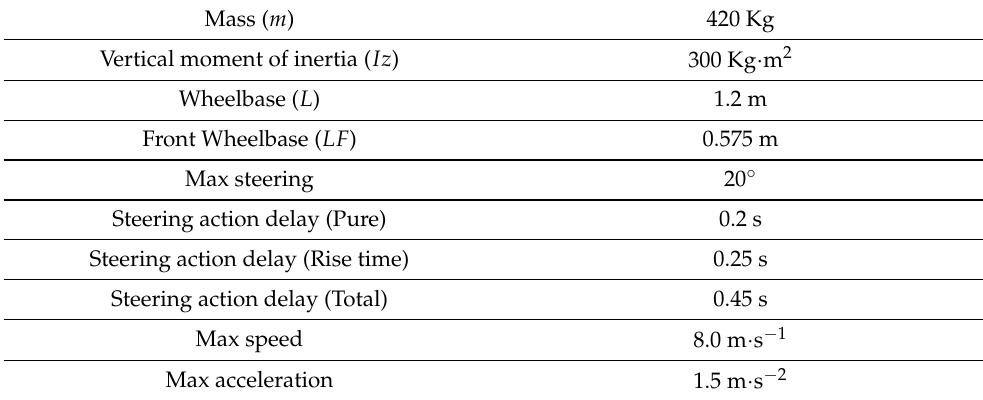
Table 3 denotes the characteristics of the RobuFAST platform: Table 3. The given RobuFAST characteristics table, for